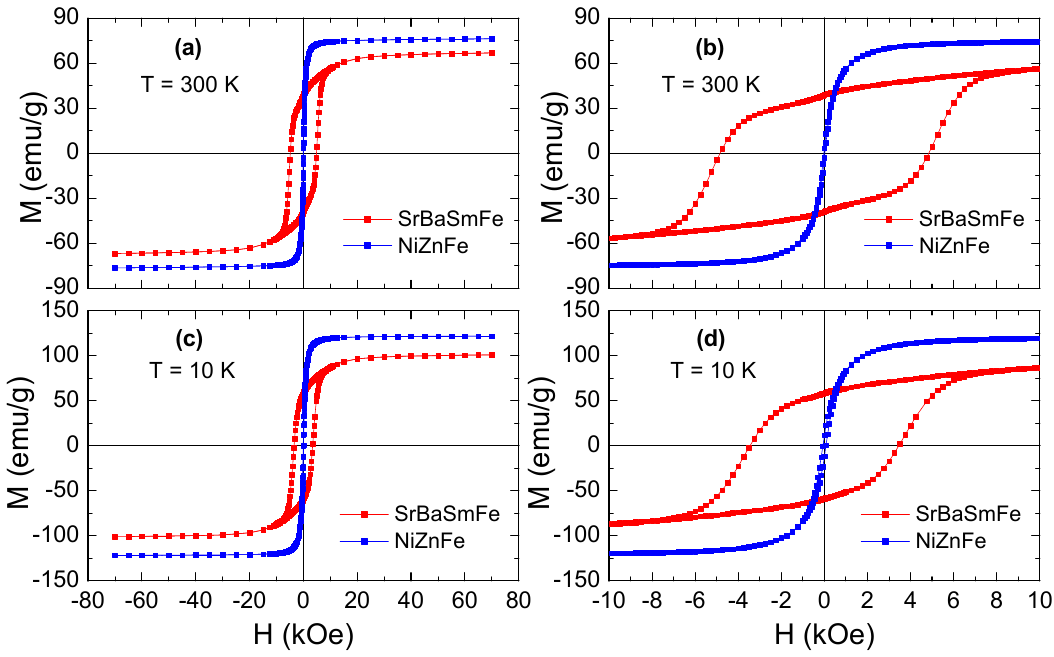
Figure 6. M(H) hysteresis curves recorded at ( a , b ) T = 300 K and ( c , d ) T = 10 K for Ni 0.8 Zn 0.2 Fe 2 O 4 (NiZnFe) and Sr 0.5 Ba 0.5 Sm 0.04 Fe 11.96 O 19 (SrBaSmFe) samples. ( b ) and ( d ) are enlarged views of magnetic hysteresis loops. In this work,